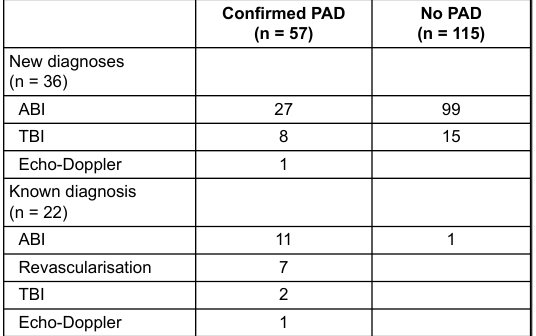
Table 4: peripheral arterial disease (PAD) prevalence and diagnostic techniques